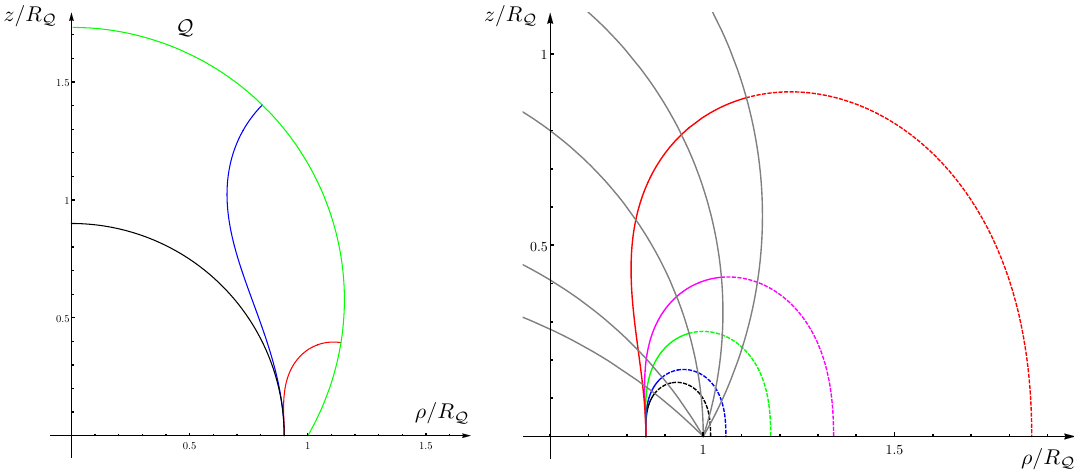
Figure 4 . Sections of the extremal surfaces anchored to a disk A of radius R (cid:14) disjoint from a circular concentric boundary with radius R Q (see section 4.1.1). Left: pro(cid:12)les corresponding to the three extremal surfaces in the case of R (cid:14) =R Q = 0 : 9 and (cid:11) = (cid:25)= 3. The green curve represents Q . The black curve corresponds to ^ (cid:13) dis (the hemisphere). The red curve and the blue curve correspond A to ^ (cid:13) con and they have been obtained through the analytic results discussed in section 4.1.1 and in A appendix B. The red curve provides the global minimum in this case. Right: extremal surfaces ^ (cid:13) con having R (cid:14) =R Q ’ 0 : 85 for di(cid:11)erent values of (cid:11) : (cid:11) = (cid:25)= 3 (red), (cid:11) = (cid:25)= 2 : 5 (magenta), (cid:11) = (cid:25)= 2 A (green), (cid:11) = 2 (cid:25)= 3 (blue) and (cid:11) = 3 (cid:25)= 4 (black). The dashed curves are the pro(cid:12)les of the auxiliary surfaces ^ (cid:13) con , with the same color code. All the pro(cid:12)les correspond to the smaller value of A; aux k whenever two surfaces ^ (cid:13) con exists. All the curves except for the red one provide the global A minimum of the corresponding